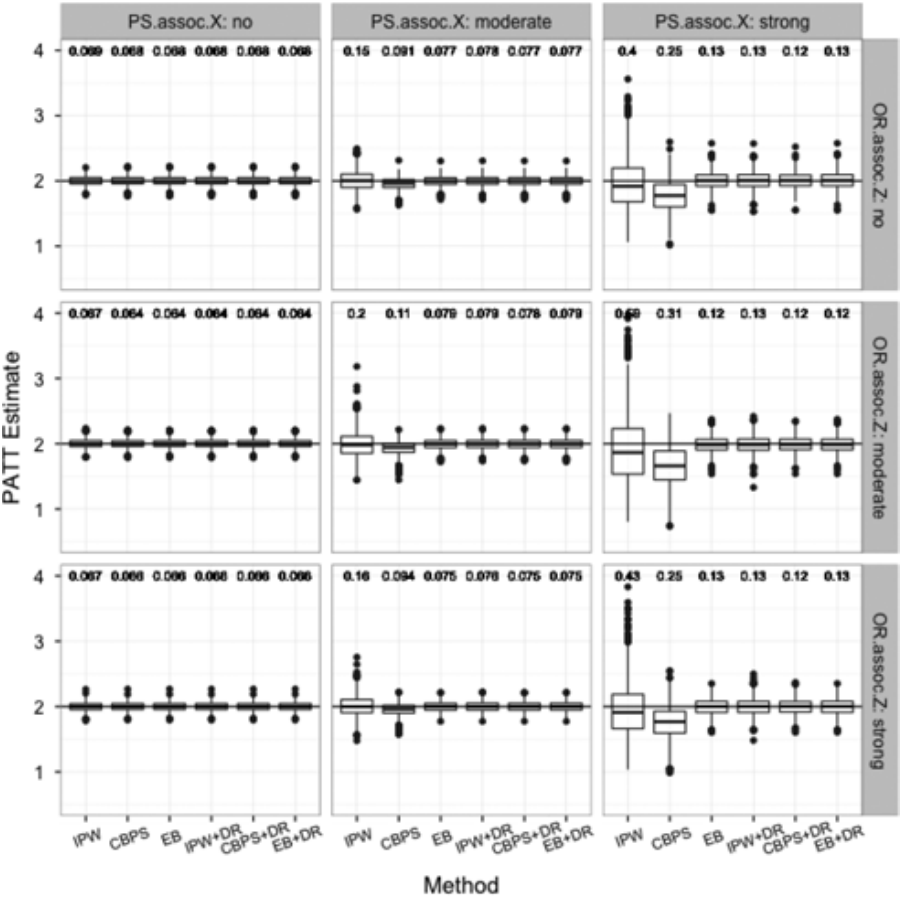
Figure 5: Results of the Lunceford-Davidian example (full propensity score modeling). The propensity score model and outcome regression model, if applies, are always correctly specified, but the level of association between T or Y with X or Z could be different, ended up with 9 different scenarios. X are confounding covariates and Z only affects the outcome. We generate 1,000 simulations of 1,000 in each scenario and apply five different estimators. The true PATT is 2 and is marked as a black horizontal line to compare the biases of the methods. Numbers printed at Y = 5 are the sample standard deviation of each method, in order to compare their